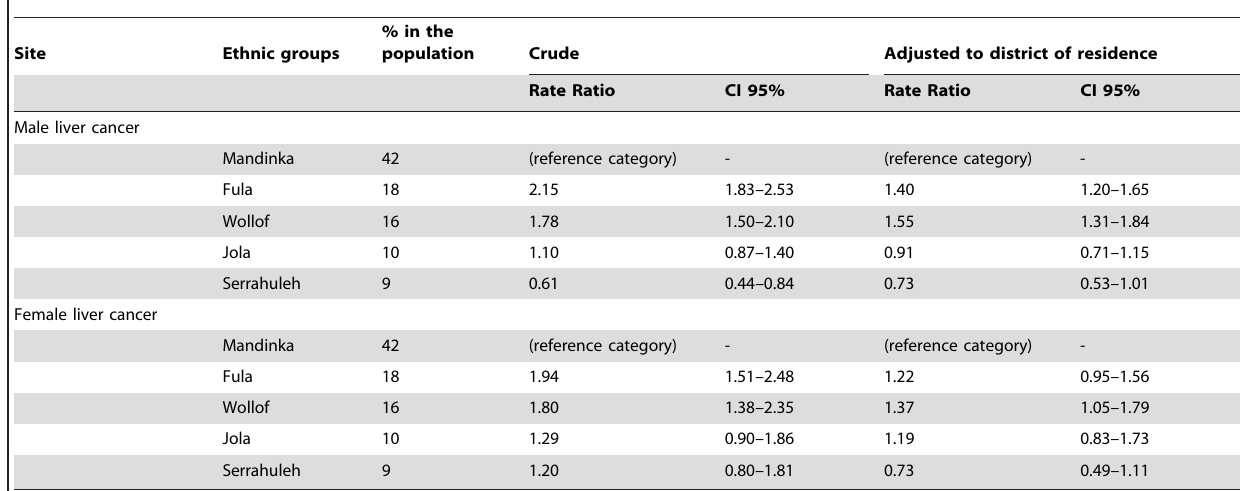
Table 3. Male and female liver cancer by ethnic groups in The Gambia